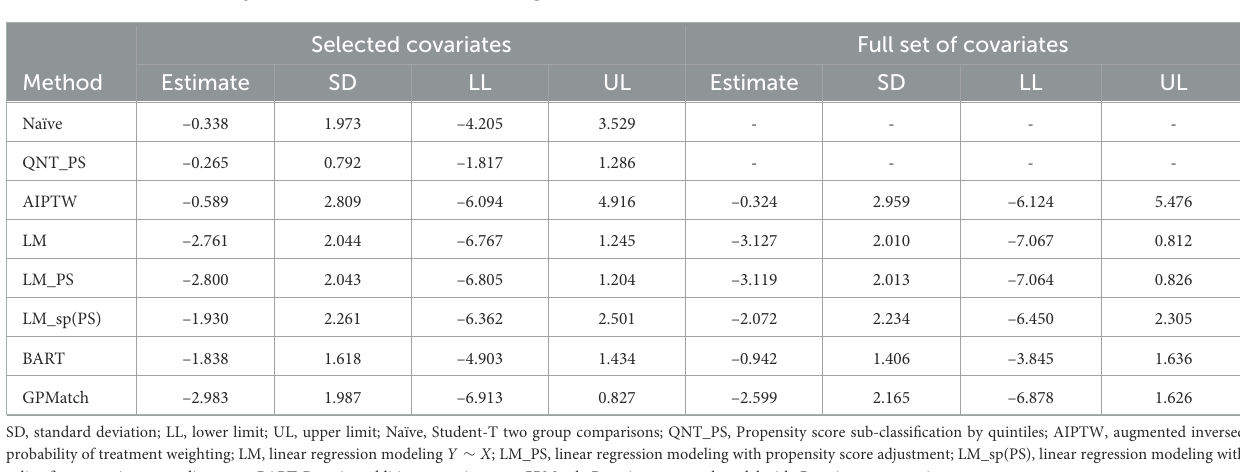
of distributions of private insurance in the treated and untreated groups, we cannot match on the insurance when the caliper was set to 1 or smaller. Thus, for calipers ≤ 1, all subjects with private insurance were being excluded. When calipers were ≤ 0.5, all subjects with positive RF were excluded, and 50% of observations were discarded. When the calipers were set at 0.2, 67 out of 75 observations were discarded, rendering the results obtained from 8 observations only! The estimate of ATE was sensitive to the choices of calipers, which ranged from –2.0 to –4.28, making it difficult to interpret the study